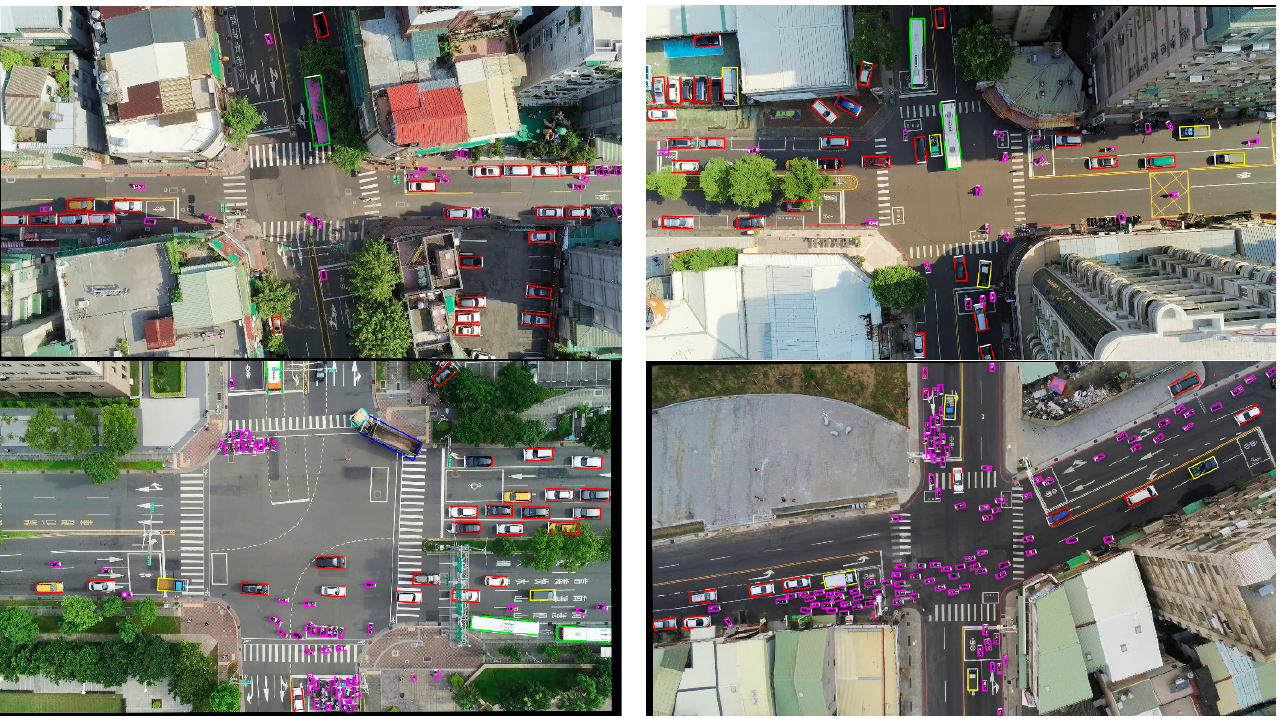
Figure 7. Detection results on our dataset. Bounding box color is defined as follows: red: sedan, yellow: truck, green: bus, cyan: tractor, blue: trailer, magenta: motorbike.